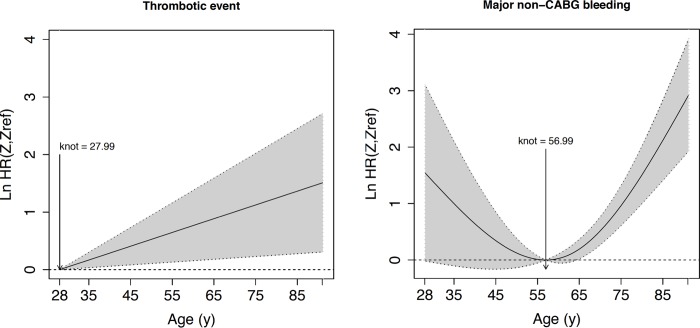
Nonparametric estimates of the dependence of the case-specific hazard ratios for major non-CABG bleeding (Fig 2A) and thrombotic events (Fig 2B) on age. Log hazard ratios with 95% confidence band are shown. The hazard ratios are relative to the age with the lowest hazard (major non-CABG bleeding: indicated knot = 57 years; thrombotic events: minimal age = 28 years). CABG, coronary artery bypass graft; LnHR, log hazard ratio; Z, specific value of age on x-axis; Zref, reference value of age with lowest hazard, i.e. indicated knot.